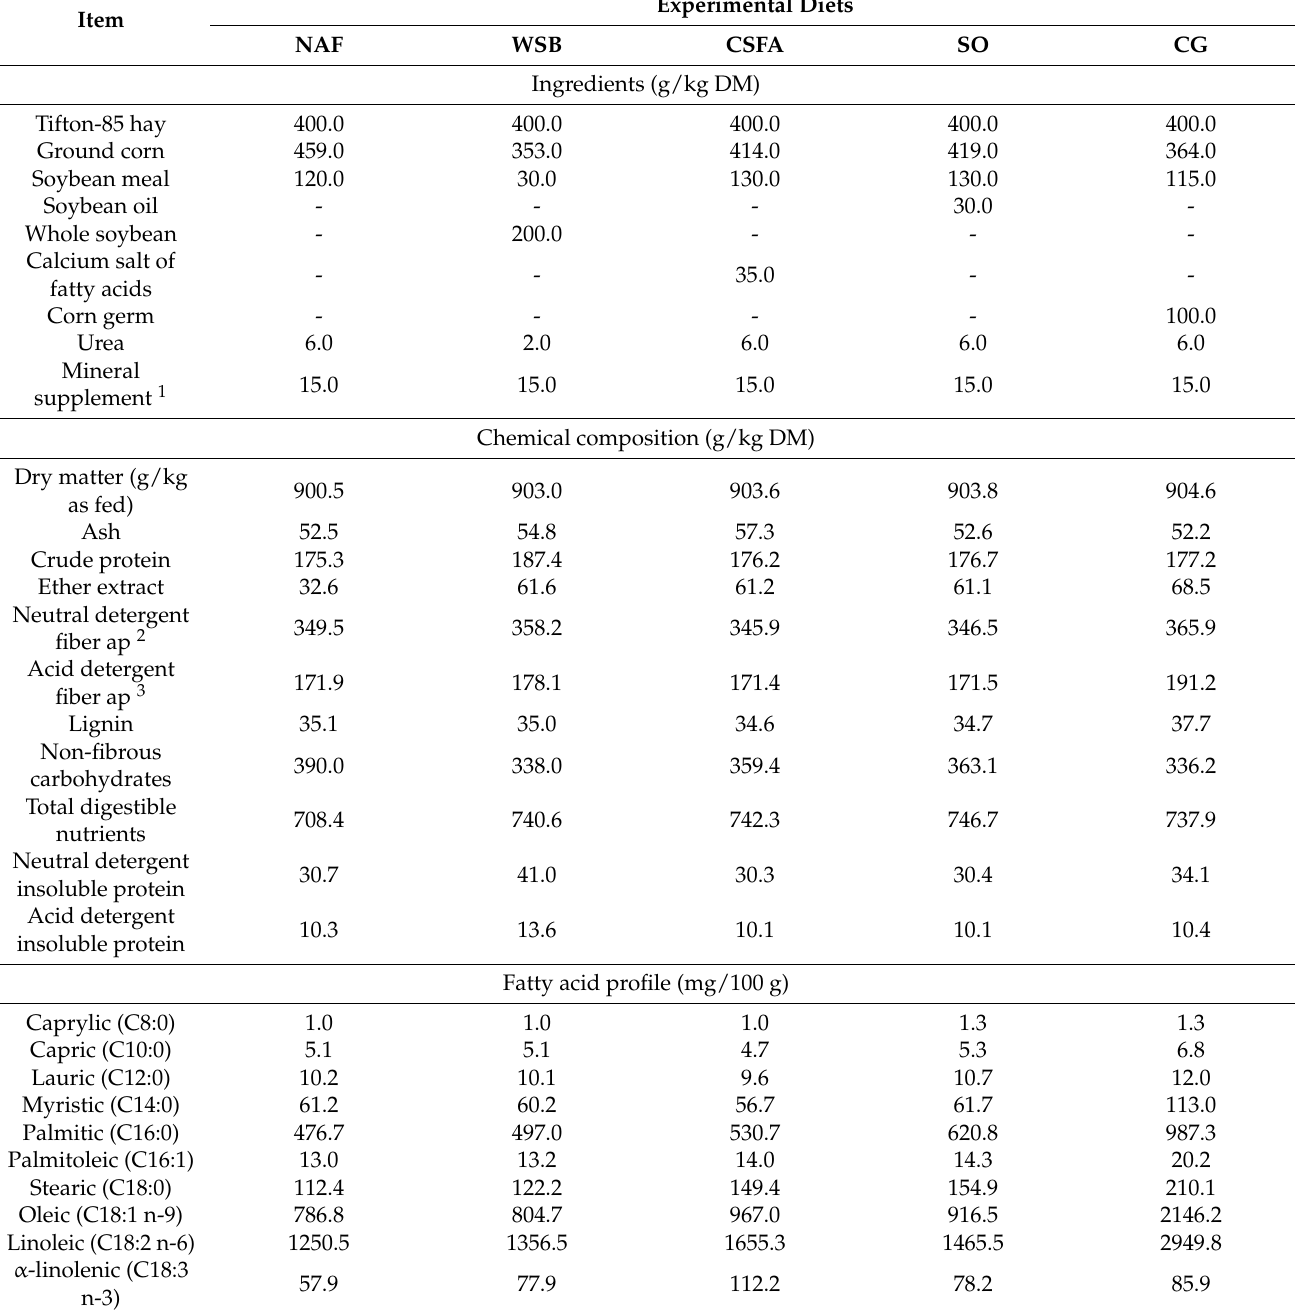
Table 1. Proportion of ingredients, chemical composition, and fatty acid profile of the experimental